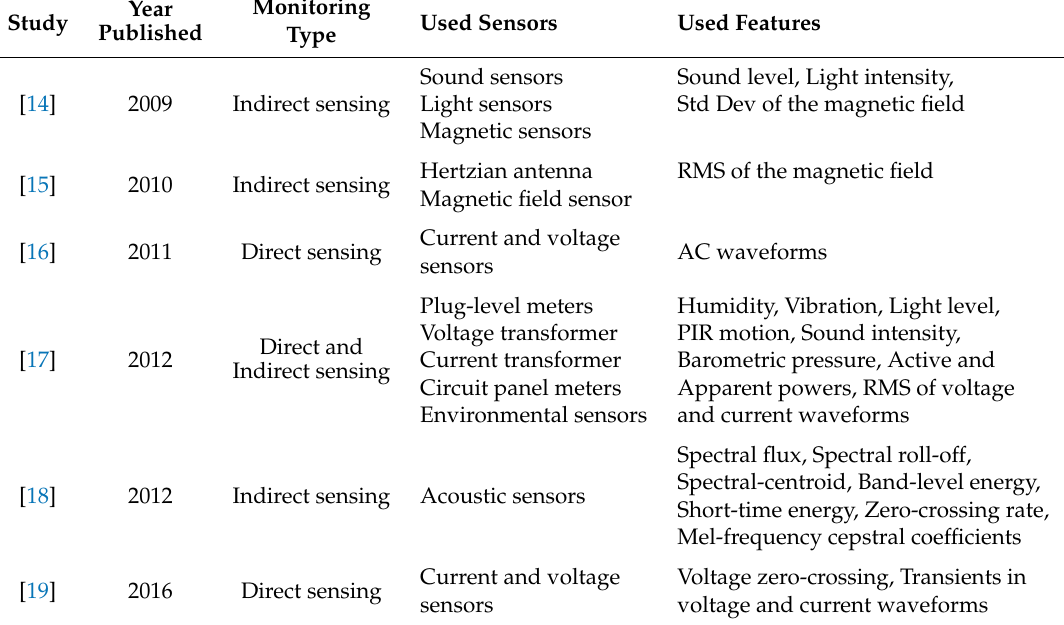
Table 1. Some of the key electric energy monitoring systems in the